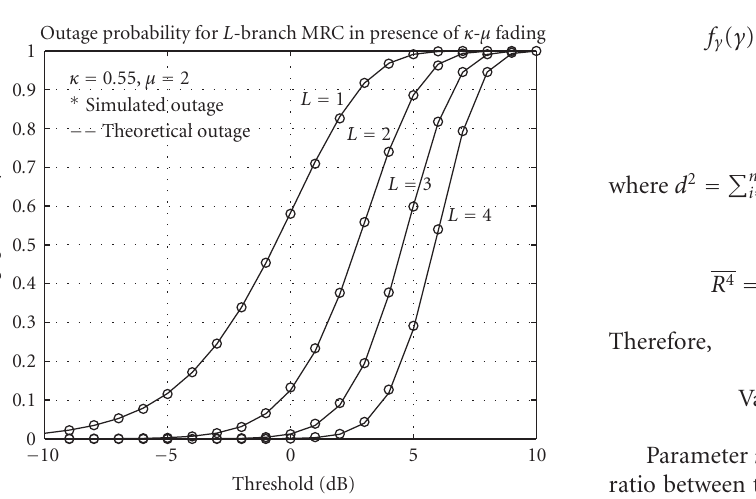
Figure 2: Outage probability for κ = 0 . 55 and μ =